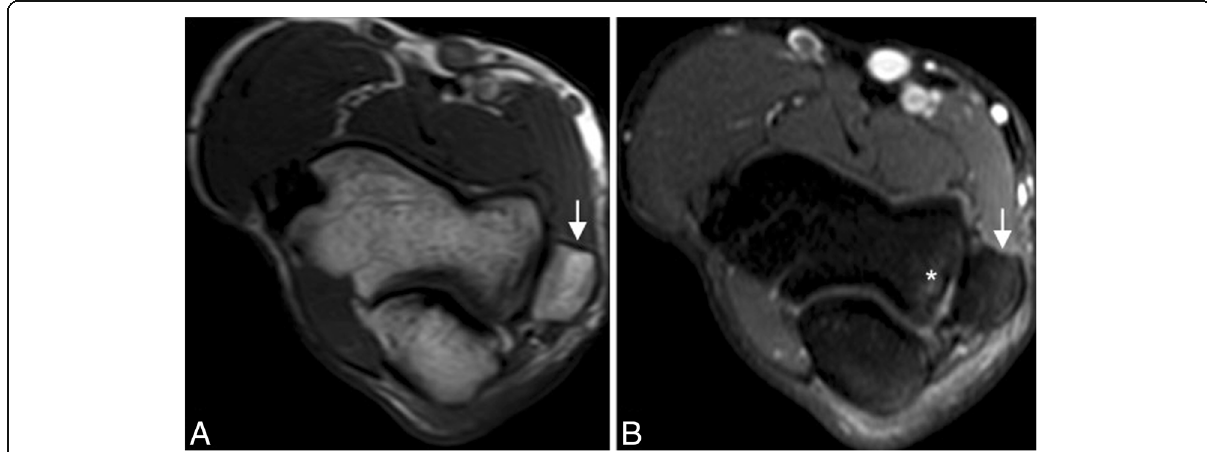
Fig. 19 A 50-year-old man with elbow pain and decreased range of motion due to an apophyseal injury sustained before physeal closure. Axial T1-weighted MRI ( a ) and axial FS PD-weighted MRI ( b ) showing chronic non-union fracture of the medial epicondyle and heterotopic ossification along the anterior band of the medial collateral ligament (white arrows). Note stress reaction, manifest as bone marrow edema (white